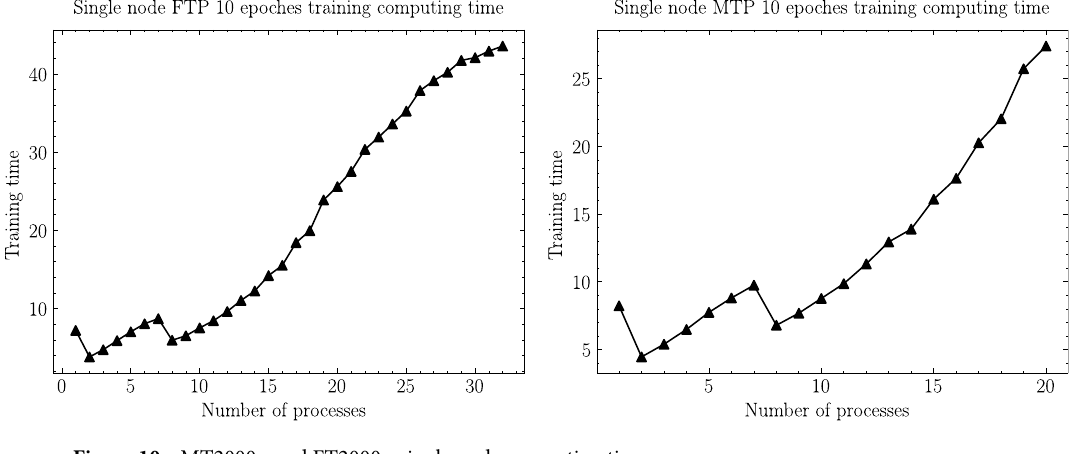
Figure 10. MT2000+ and FT2000+ single node computing